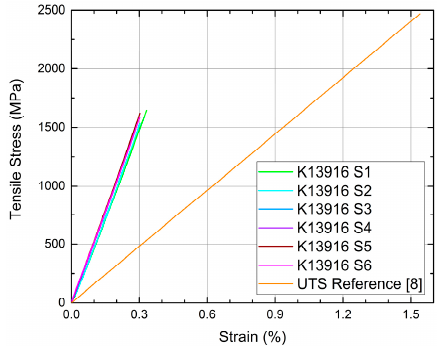
Figure 2. Tensile stress versus strain response of new UHM CFRP tendons (6 specimens labelled K13916 S1 to S6), compared with a conventional CFRP prestressing tendon [8].